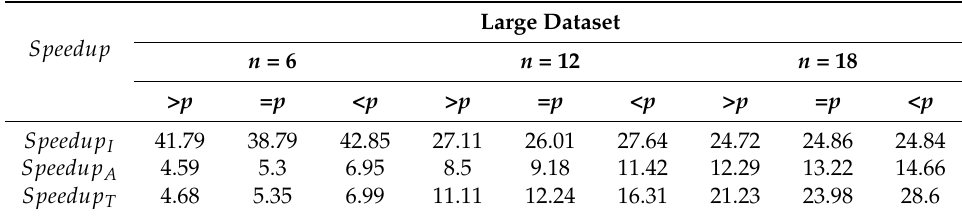
Table 5. Speedup obtained with a single card on Shelob (large dataset).